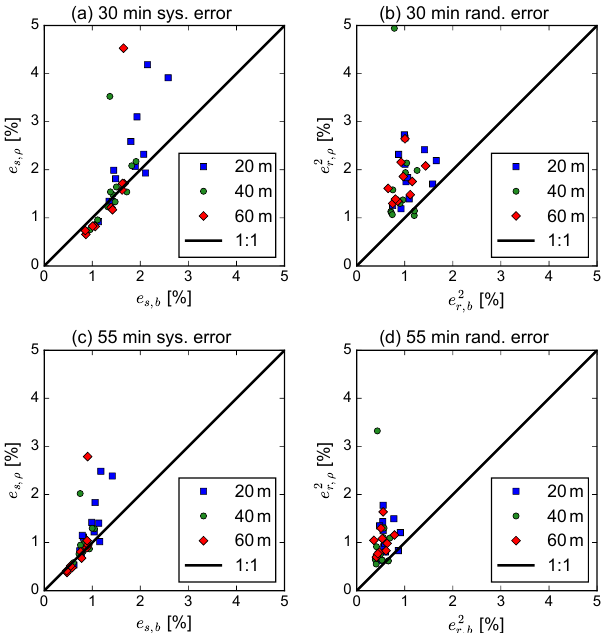
Figure 10. Comparison of lidar radial velocity systematic errors e s ,ρ and e s , b estimated using the autocorrelation ( M ρ ) method and the stationary bootstrap ( M b ) methods, respectively, for (a) a sam- pling duration of 30min and (c) a sampling duration of 55min, and comparison of the lidar radial velocity random errors e 2 r ,ρ and e 2 estimated using the M ρ method and the M b method, respectively, for (b) a sampling duration of 30min and (d) a sampling duration of 55min. The measurement heights are shown in the legend.